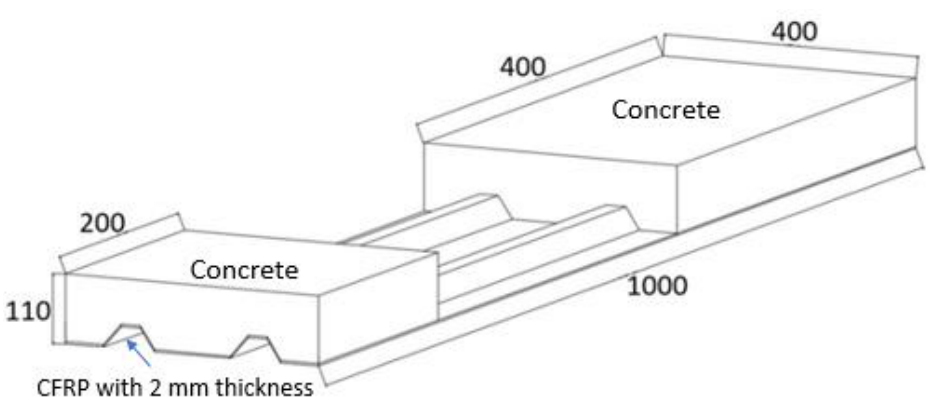
Figure 1. Geometry of the specimens (dimensions are in millimeters).